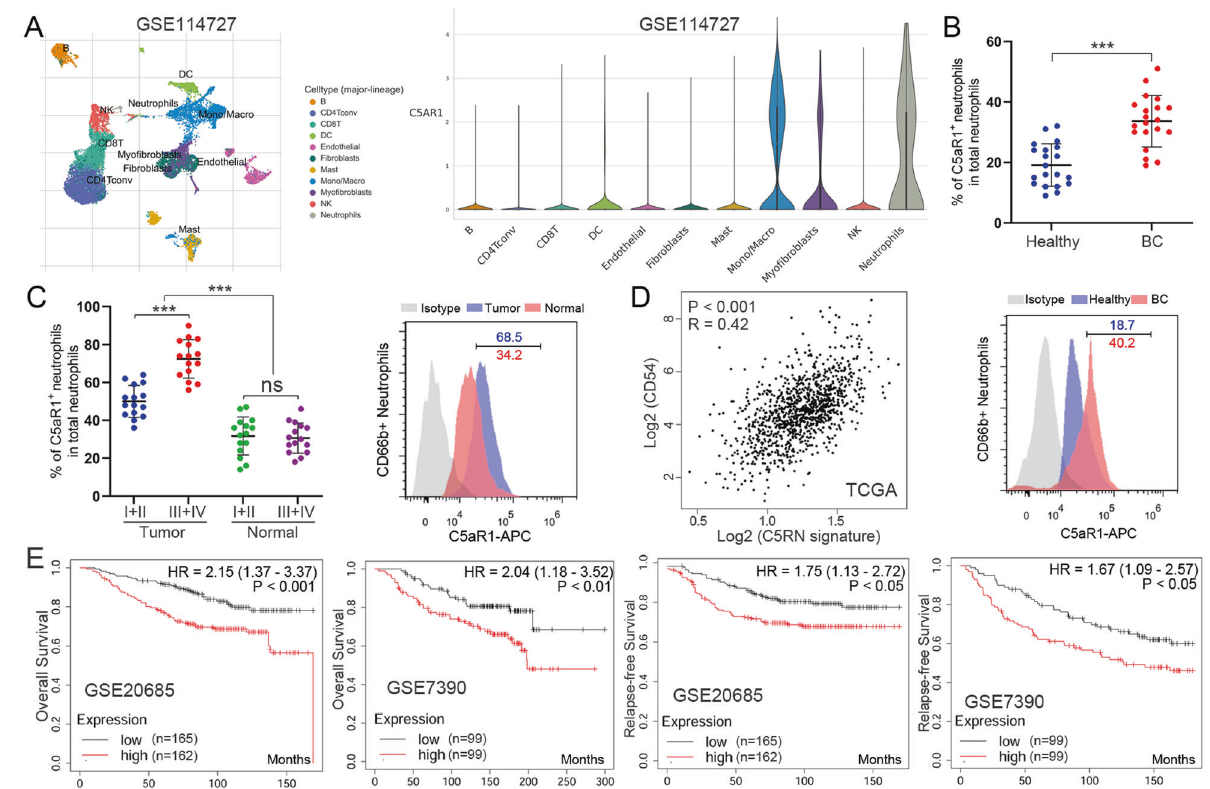
Fig. 1 C5aR1 + neutrophils accumulate in breast cancer with disease progression and poor patient survival. A t -Distributed stochastic neighbor embedding plot of single-cell RNA-seq data from GSE114727. Identi fi ed clusters are represented by different colors (left). Violin plots showing expression of the indicated transcripts in each different cell type (right). B C5aR1 + neutrophil percentage in total CD66b + neutrophils in peripheral blood from healthy donors or BC patients (top). Representative image of C5aR1 staining in CD66b + neutrophils (bottom). C C5aR1 + neutrophil percentage in CD66b + neutrophils in each tissue of patients with BC (left). Representative image of C5aR1 staining in CD66b + neutrophils (bottom) (right). D The correlation between C5aR1 + neutrophil gene signature (CD66b, CD15, and C5aR1) and CD54